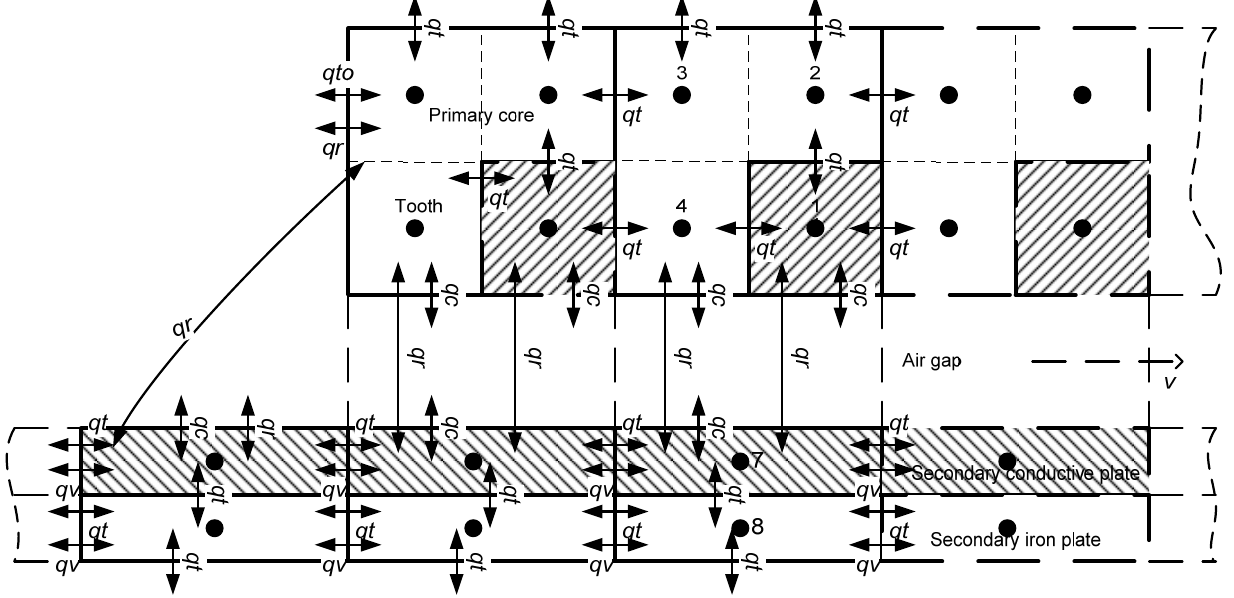
Figure 1. Thermal model of the LIM—longitudinal section.